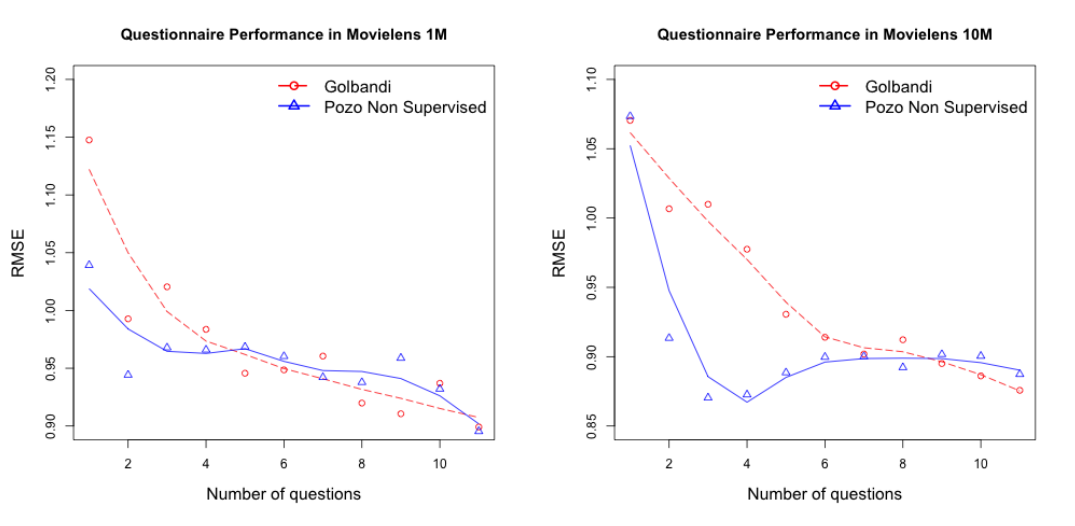
Figure 4. Questionnaire performance in